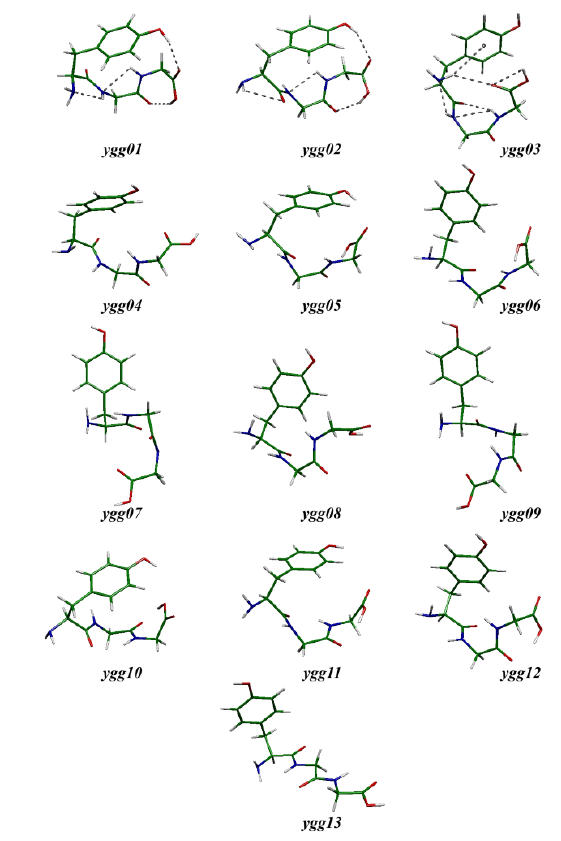
a The global minimum corresponds to the final geometry 01 (see Supplemental Table 2) having a total energy of -1039.9044926 hartree. This value is taken as reference value, corresponding to a relative energy 0.00 kcal mol -1